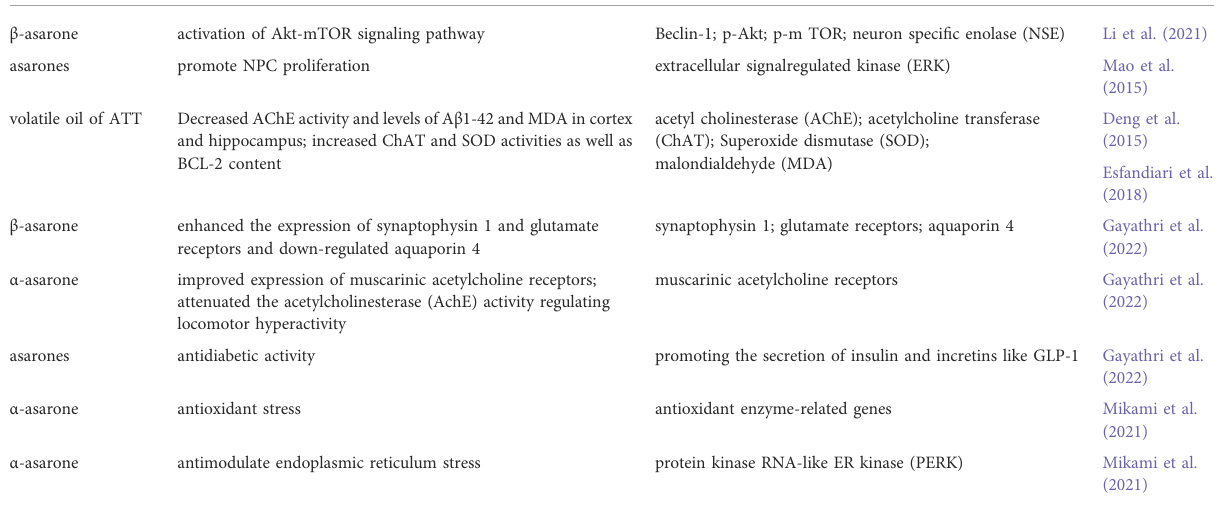
TABLE 4 The targets and mechanisms of VOA in Alzheimer ’ s disease.